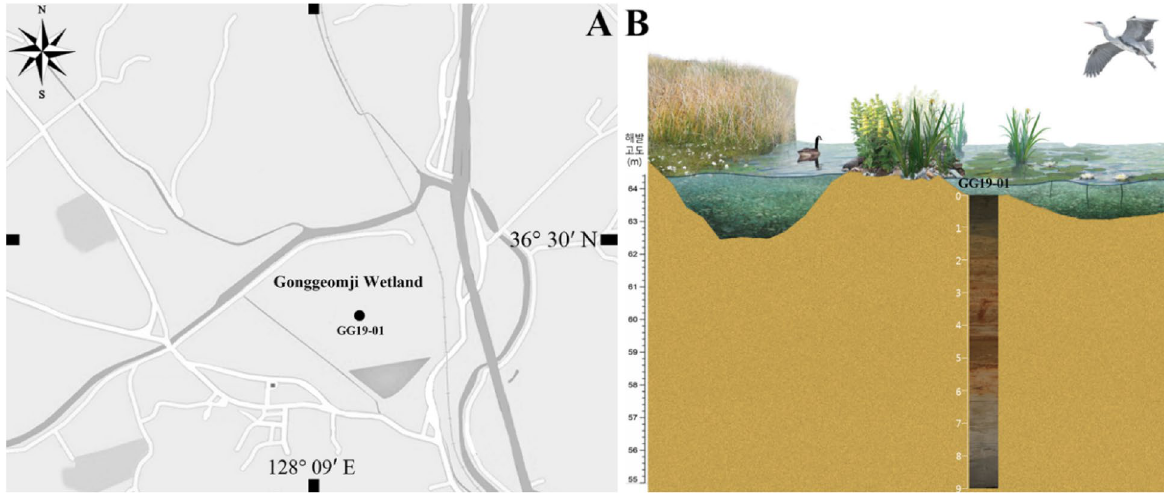
Fig. 1 Map of the study area ( A ) and drilling location ( B